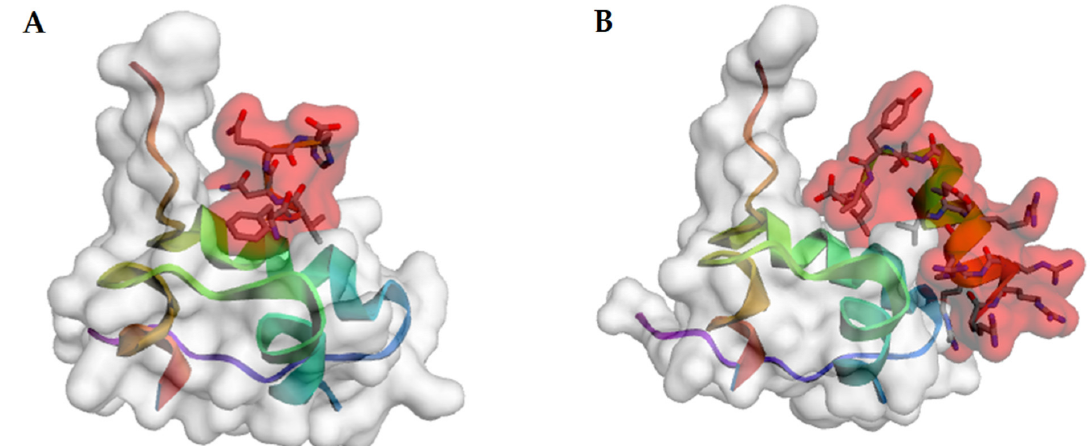
Figure 11. Docking model of insulin monomer (PDB file 1guj) with peptide FVNQH ( A ) and with peptide RRRRRRLVEALYLV ( B ), obtained using the CABS-dock (CABS-dock. Available online: http://biocomp.chem.uw.edu.pl/CABSdock (accessed on 17 December 2022)). The peptide region is shown in